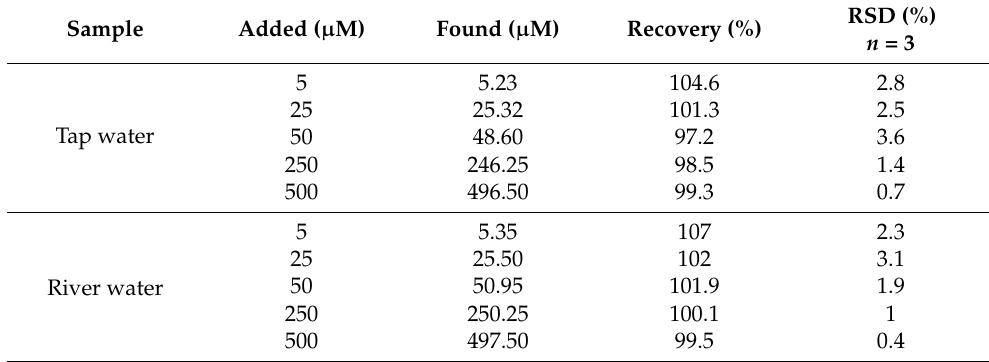
Table 2. The determination of real water samples with nitrite